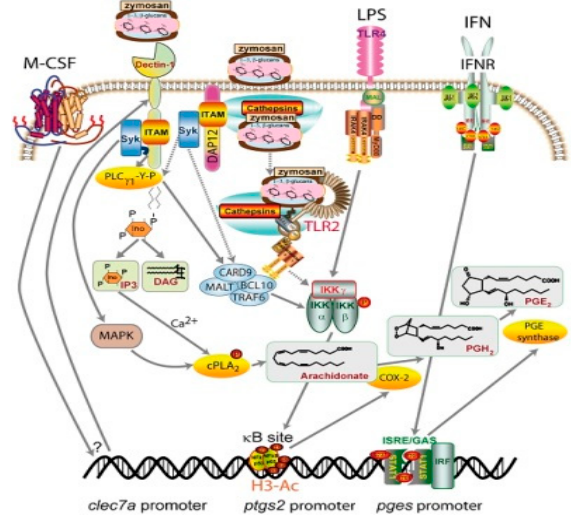
Figure 3. Proposed mechanisms involved in glucan/zymosan uptake and signaling in human macrophages. Zymosan particles can activate Syk via Dectin-1 engagement and via adaptor protein DAP12. Upon internalization, TLR2 recognition and cathepsin B leakage occur. In the presence of M-CSF, the expression of Dectin-1 B isoform is increased. Concomitant mechanisms of NF- κ B activation might be triggered. cPLA 2 is activated by Dectin-1/Syk-dependent mechanisms involving MAPK-dependent Ser-505 phosphotylation and Ca 2+ -dependent membrane translocation. Dotted lines indicate the steps associated with phagocytic cargo processing. Ac-H3 indicates acetylated histone 3. From (Municio et al., 2013) [51].